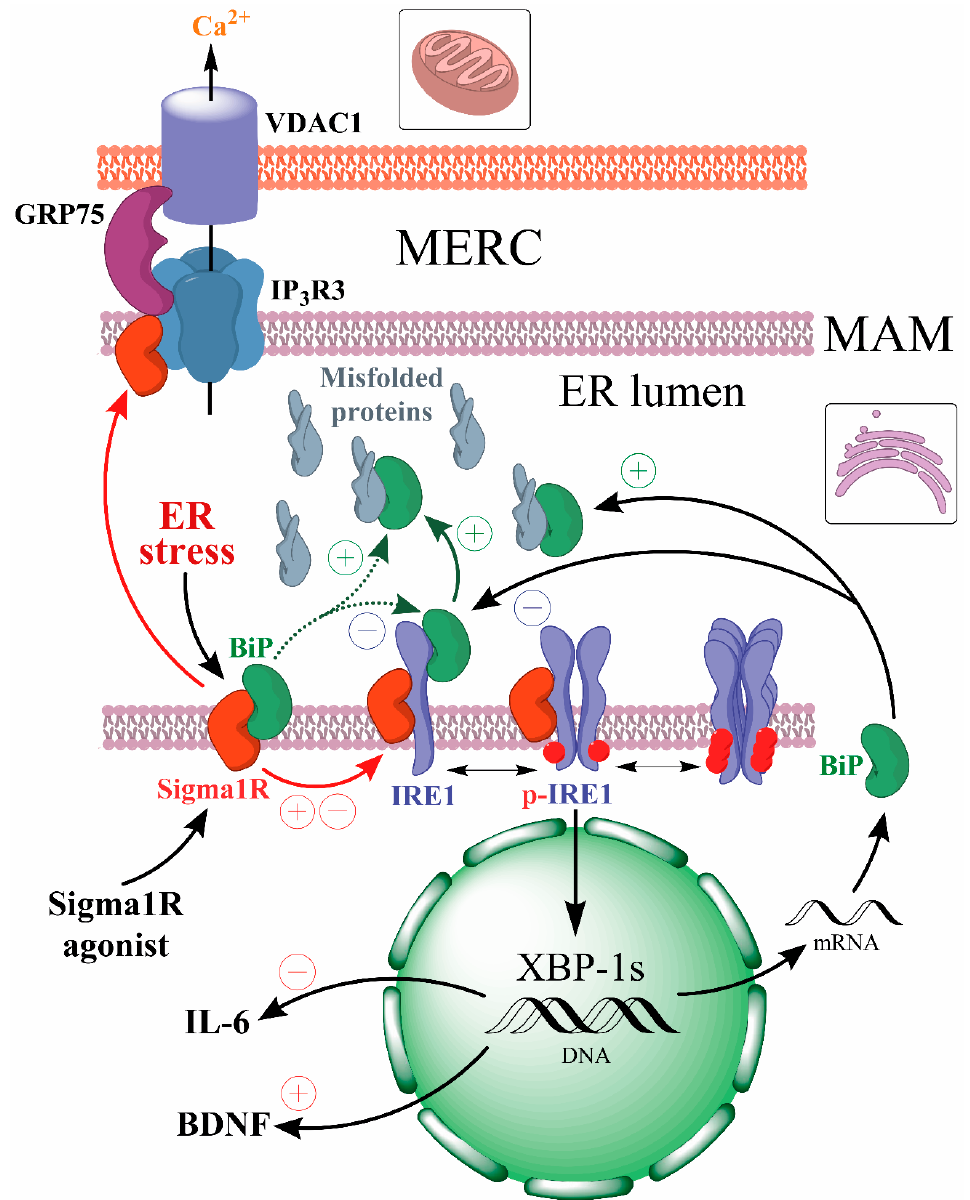
Figure 5. Possible mechanisms of Sigma1R-dependent neuroprotection through UPR regulation. Sigma1R activation under ER stress conditions or Sigma1R ligands with agonist properties action causes dissociation of the Sigma1R-BiP chaperone complex. The dissociation of the Sigma1R-BiP complex enhances the chaperone activity of BiP on misfolded proteins and the regulatory effects of Sigma1R on client proteins (IP 3 R3, IRE1 α ). The regulatory effects of activated Sigma1R on IRE1 α cause an increase in BiP and BDNF expression and a decrease in proinflammatory interleukin expression. Thus, Sigma1R activation contributes to endogenous neuroprotective mechanisms aimed at attenuating ER stress and neuroinflammation while enhancing neuroplasticity. —BiP activation, —IRE1 α inhibition, —Sigma1R-dependent positive regulation, — Sigma1R-dependent negative regulation, —Translocation of activated Sigma1R, — hypothetical fast Sigma1R-dependent BiP activation.